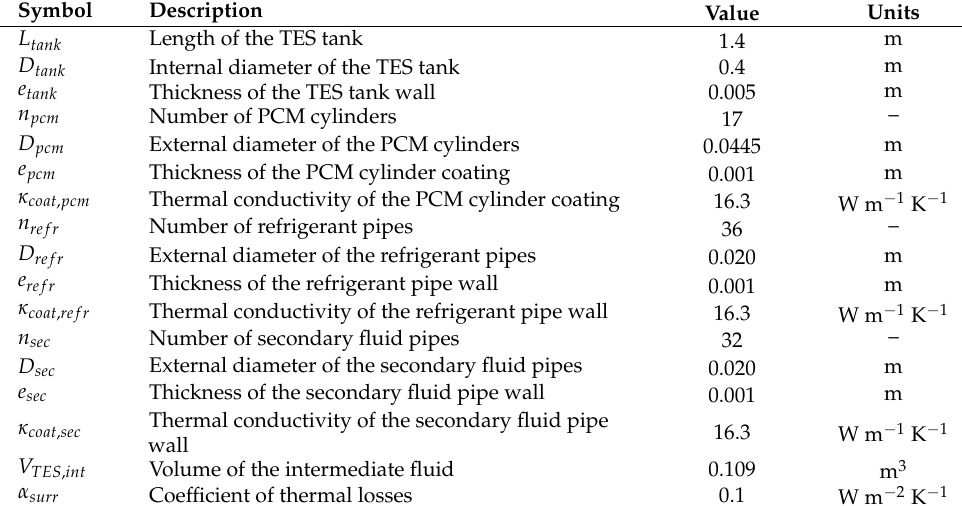
Table 2. Design parameters of the TES tank.